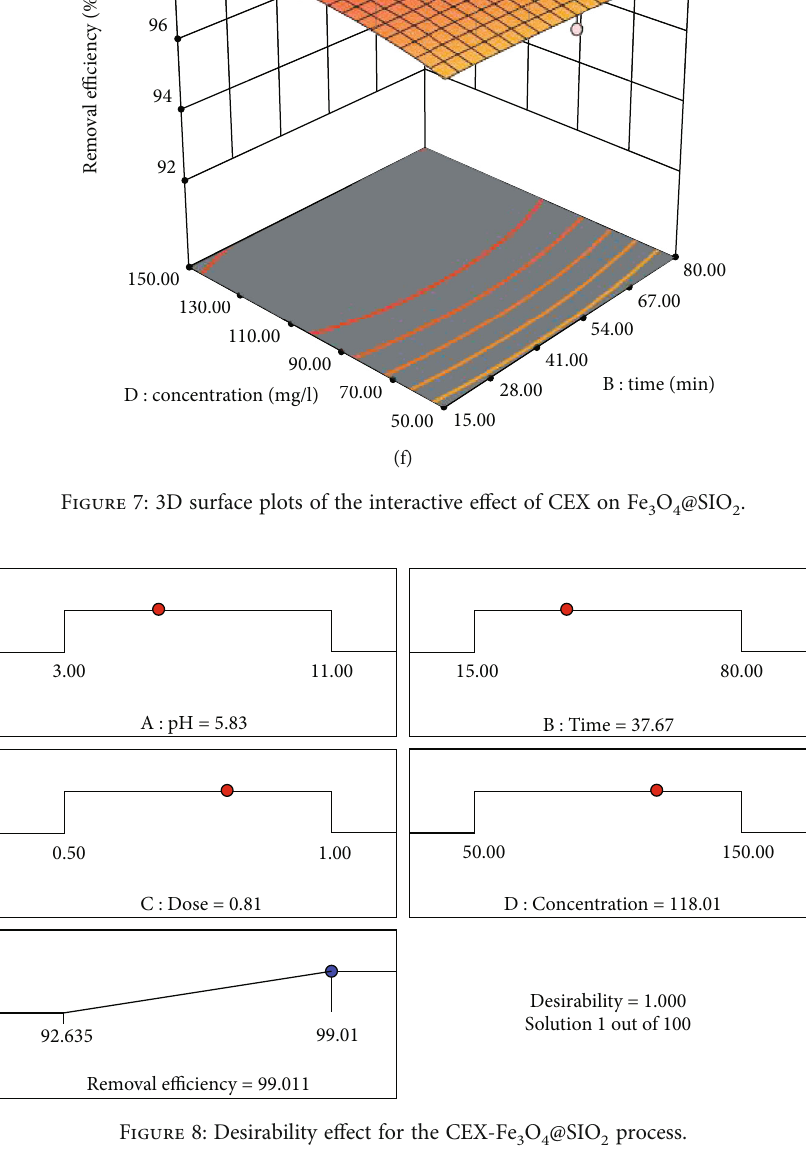
O @SIO process. 3 4 2